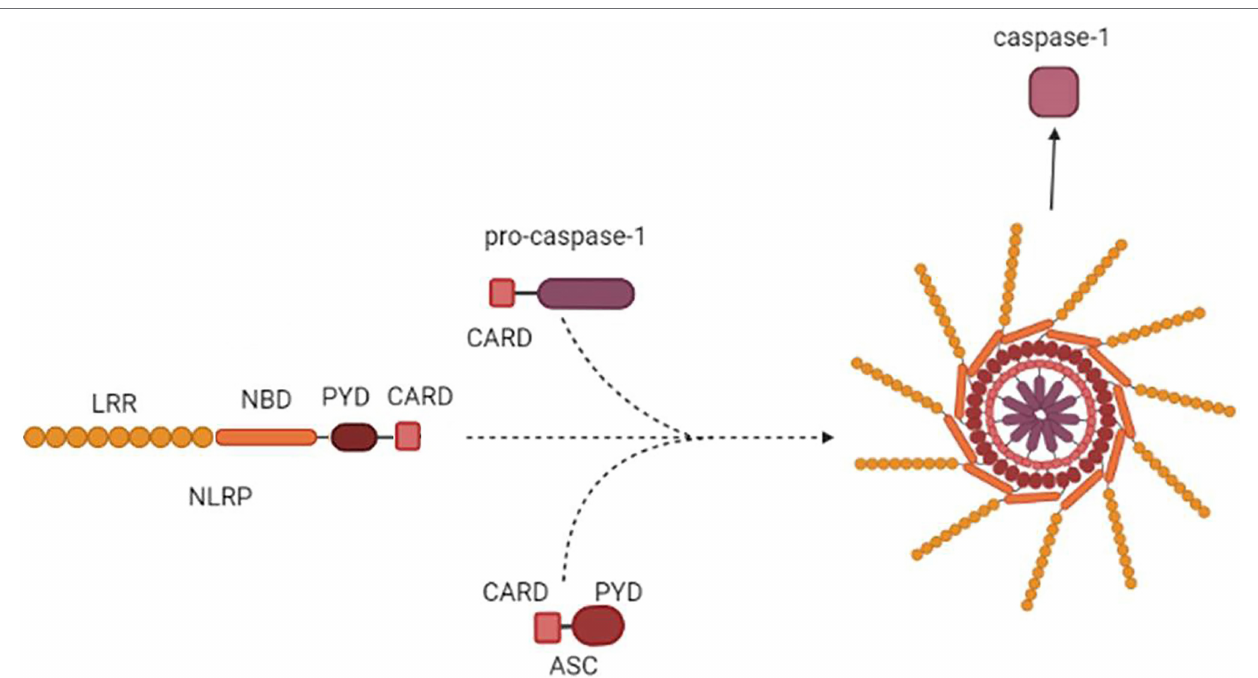
FIGURE 2 | Inflammasome assembly. NLRP3 is used as an example to demonstrate inflammasome assembly. NALRP3 PYD-CARD polymerizes with PYD-CARD of an ASC adaptor. The adaptor CARD then forms a dimer with CARD of pro-caspase-1. The macromolecule formed by oligomerized NLRP3-ASC-pro-caspase-1 complex is assembled into the multi-subunit, wheel-shaped inflammasome complex, which releases active